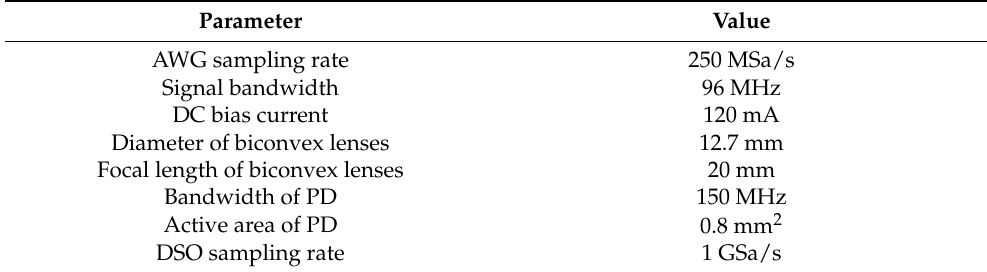
Table 3. Experimental